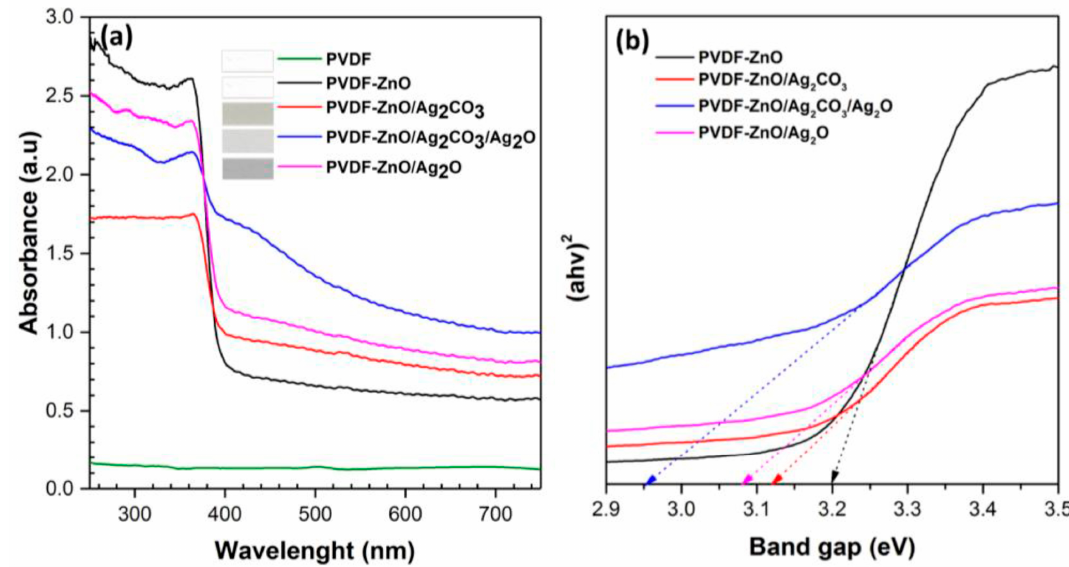
Figure 2. ( a ) Absorbance spectra, ( b ) band gap determination by drawing the line at ( α h υ ) 2 of the electrospun nanofibers. For polyvinylidene fluoride (PVDF), no band gap could be calculated since the absorbance was too low. From [55], copyright (2019), originally published under a CC-BY license. Using this technique, Matysiak et al. characterized the different blends of poly(acrylonitrile) (PAN) with the conductive polymers polypyrrole (PPy), polythiophene (PT), and polyani- line (PAni) and found a reduction in the band gap of pure PAN (4.08 eV) to minimum 3.77 eV for composite nanofibers containing 3% PAni [58]. Interestingly, Bayan et al. even they used to improve the charge transport in the buffer layer of organic solar cells